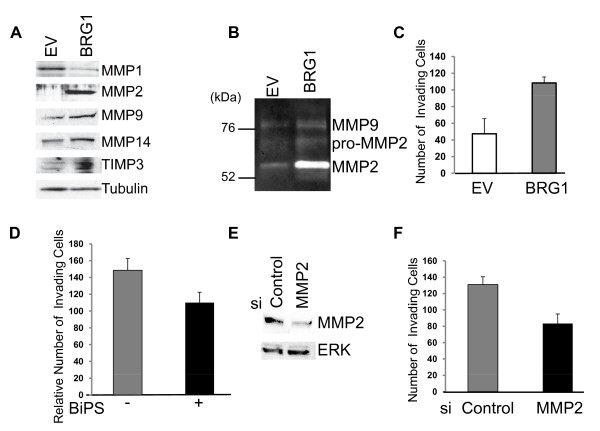
MMP2 activity is up-regulated in BRG1 expressing SK-MEL5 cells and promotes invasion through matrigel. A. Detection of MMP and TIMP protein expression by Western blotting. Tubulin is a loading control. B. MMP activity in control (EV) and SK-MEL5 expressing BRG1 was determined by zymography. Cells were cultured in serum free media for 24 hours and the supernatant collected and normalized to cell number. C. Invasion assays were performed using matrigel coated chambers with 5% FBS as a chemoattractant. Control SK-MEL5 cells (EV) and SK-MEL5 cells expressing BRG1 were seeded at a density of 1.25 × 105 cells per well on top of control or matrigel inserts. Percent invasion through matrigel was calculated relative to migration through the control insert. The data shown is the average of two independent experiments done in triplicate. Expression of BRG1 significantly increased invasion (p < 0.01). D. Vehicle treated (DMSO) or BiPS (10μM) treated BRG1 expressing SK-MEL5 cells were subjected to the invasion assay as described in C. The data shown is representative of two independent experiments performed in duplicate. Treatment with the MMP2/MMP9 inhibitor, BiPS significantly inhibited invasion (p < 0.01). E. SK-MEL5 +BRG1 cells were transfected with Acell SMART Pool siRNAs targeting MMP2 or red non-targeting siRNAs and analyzed by Western blotting 120 hours after transfection. F. Control and MMP2 down-regulated SK-MEL5+BRG1 cells were subjected to the invasion assay as described in C, 120 hours after transfection with siRNAs. Invasion assays were performed in triplicate. Down-regulation of MMP2 significantly compromised invasion (p < 0.01).